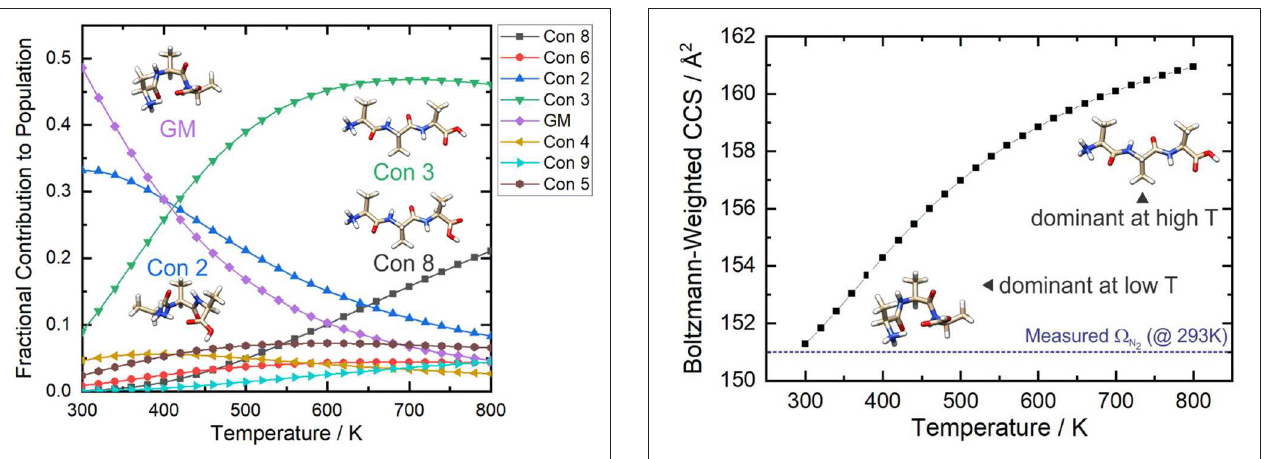
FIGURE 9 | The relative populations of the low energy conformers of protonated alanine tripeptide, [AAA calculations over the temperature range T conducted at the B3LYP/6-311 implemented in Gaussian 16 (Frisch et al., 2016). Conformers are numbered in order of increasing energy relative to that of the global minimum (GM; i.e., conformer 1) structure.